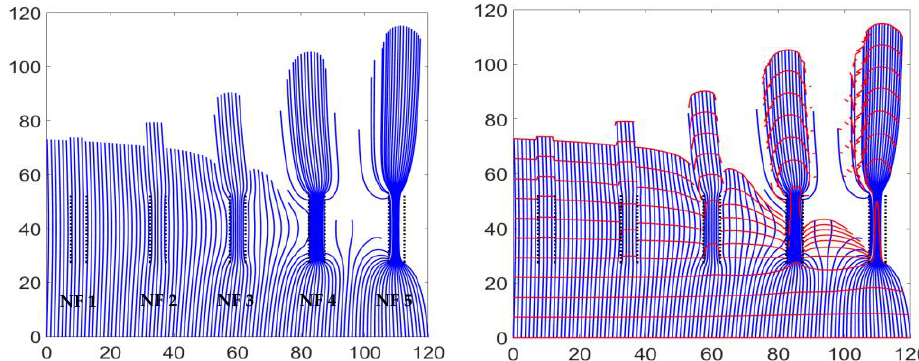
Figure 5. REV model showing impact of different natural fracture (NF) permeability on FP and TOF in a reservoir space of 5% porosity. NF (dashed black lines) strengths from left to right: NF 1 = 0.1 ft 4 /year, NF 2 = 40 ft 4 /year, NF 3 = 160 ft 4 /year, NF 4 = 500 ft 4 /year, NF 5 = 1000 ft 4 /year. Streamlines in blue (left side) and TOFC in red (right side).